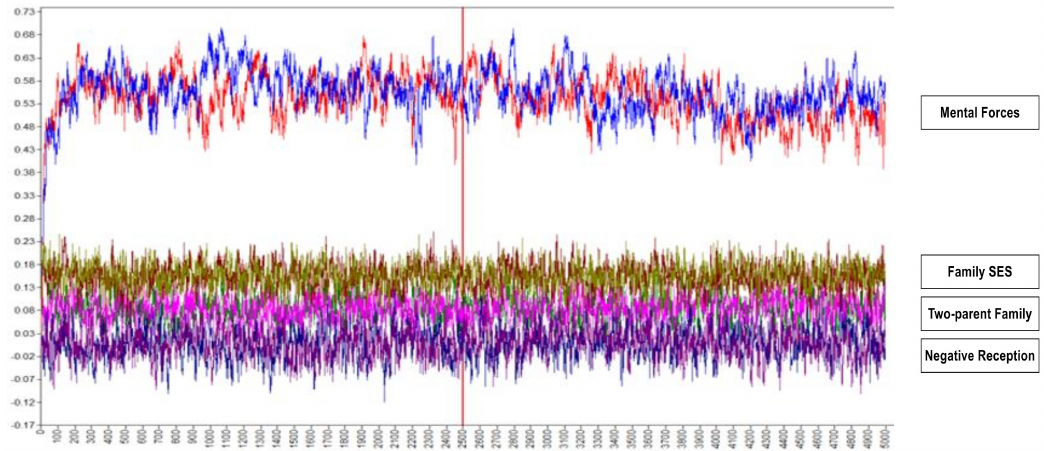
Figure A2. Bayesian posterior parameters trace plot presenting the effects of mental forces, two- parent families, family SES, and negative reception in parallel on immigrant children’s engagement in postgraduate study. Note: The number of iterations for each Markov Chain Monte Carlo chain was modeled by setting Fbiterations = 5000 for repeated random sampling, and all individual- and school-level covariates of multilevel modeling were adjusted, PSR =